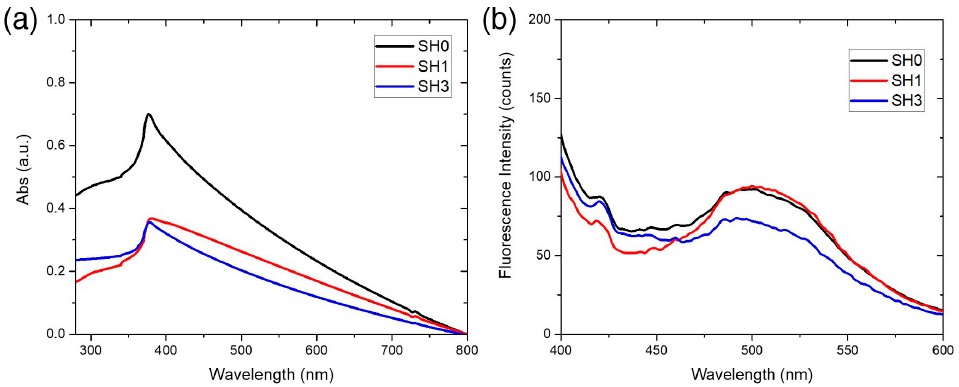
Figure 2. Optical characterization of ZnO-T samples SH0, SH1, and SH2. ( a ) UV-Vis absorption spectra showing an absorption peak at 370 nm. ( b ) Fluorescence spectra of the samples excited at 370 nm.